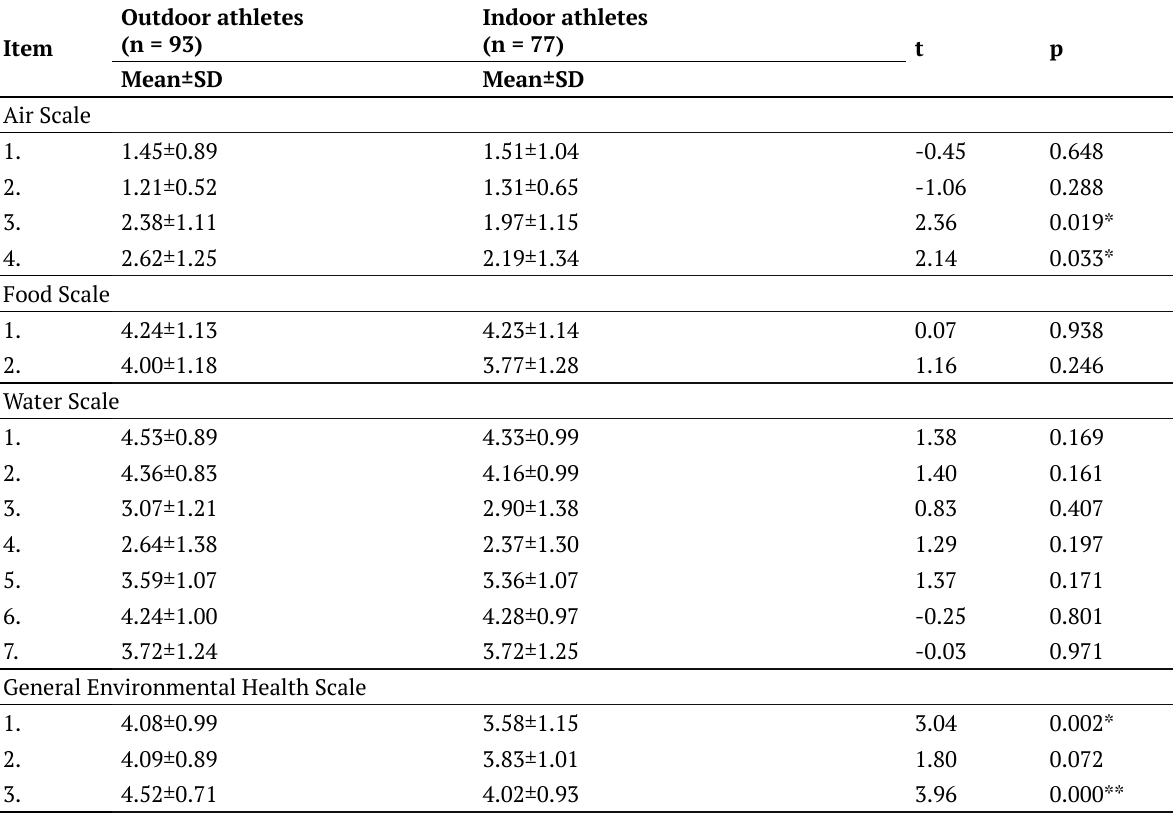
Table 2. Behaviour declared by men and women within Environmental Health Literacy